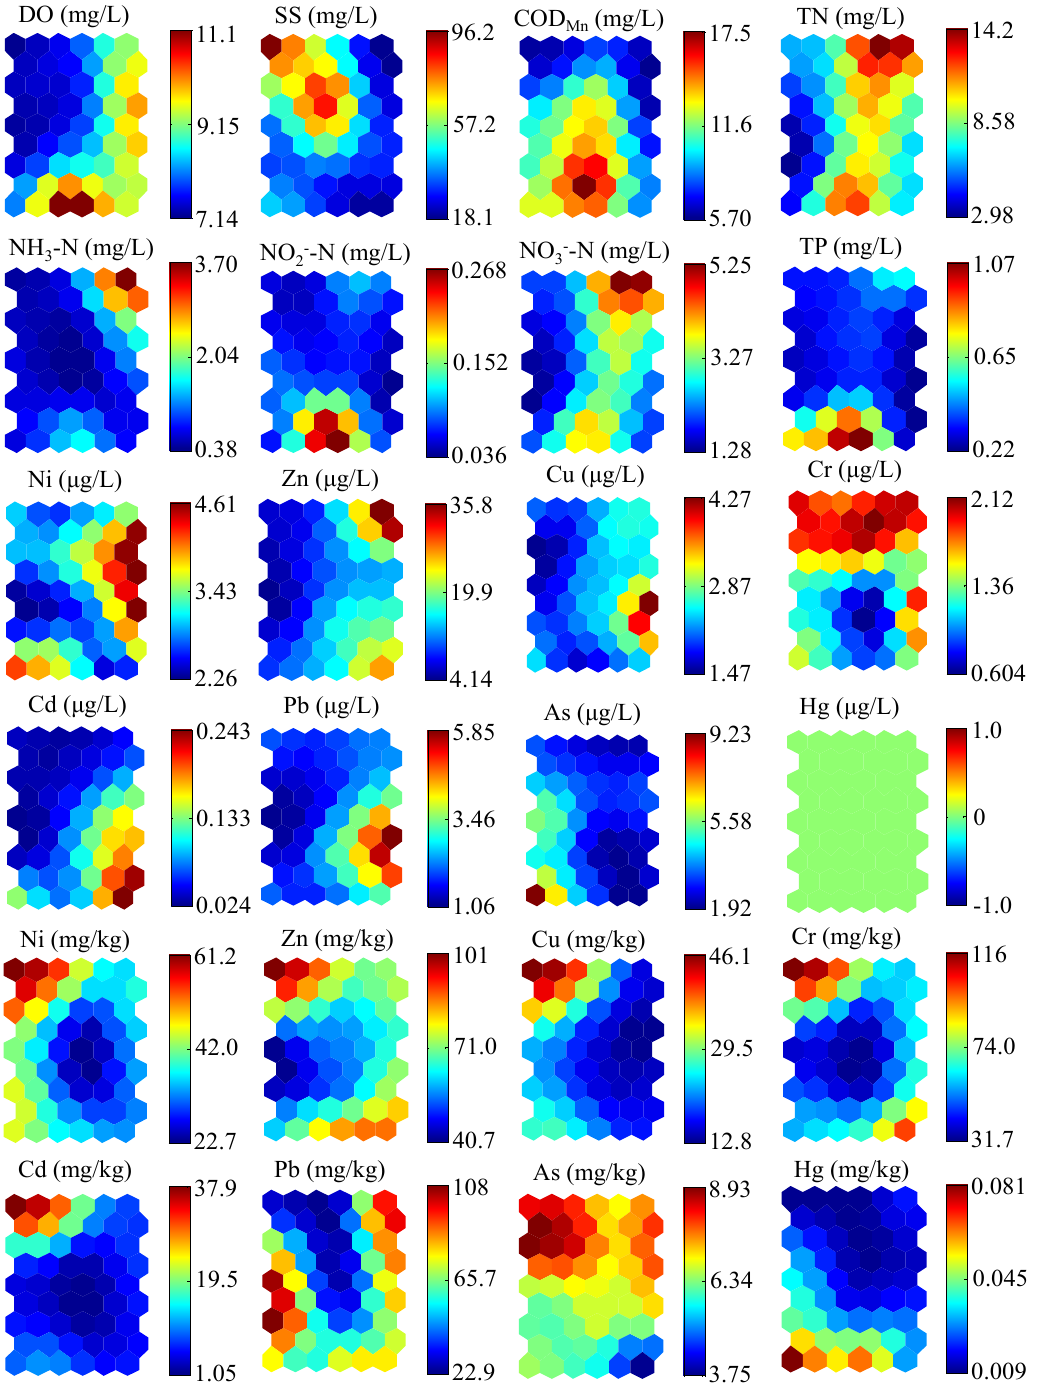
Figure 7. Visualization of environmental variables in waters and sediments. The mean value for each variable was calculated in each output neuron of the SOM previously trained with macroinvertebrate data.